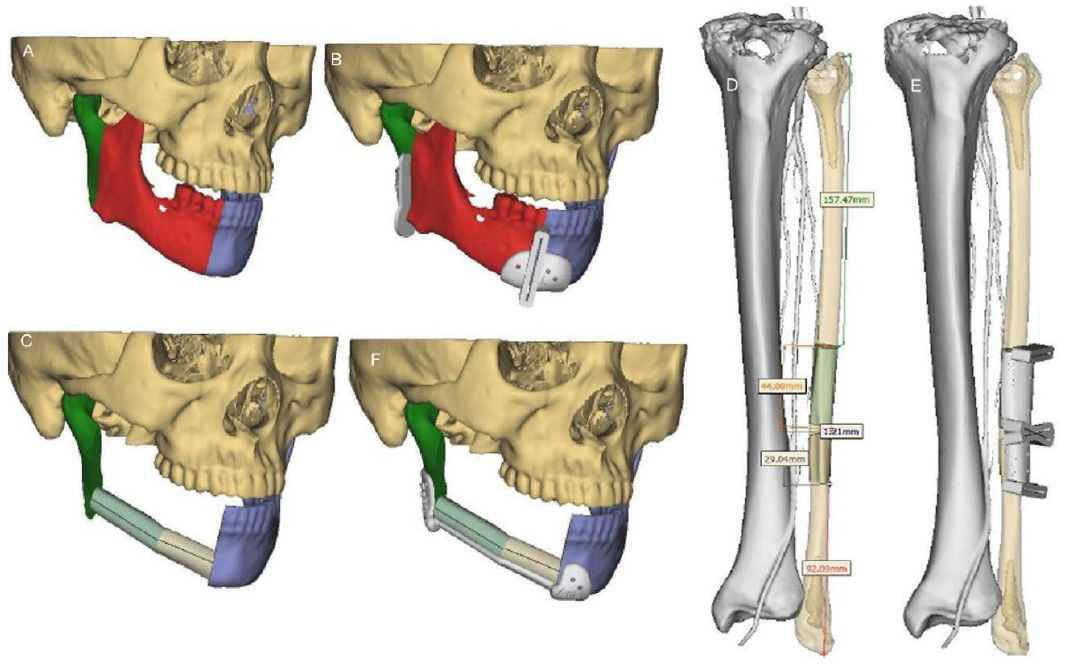
Figure 3. ( A , B ) Three-dimensional mandibular resection and design of the mandibular resection